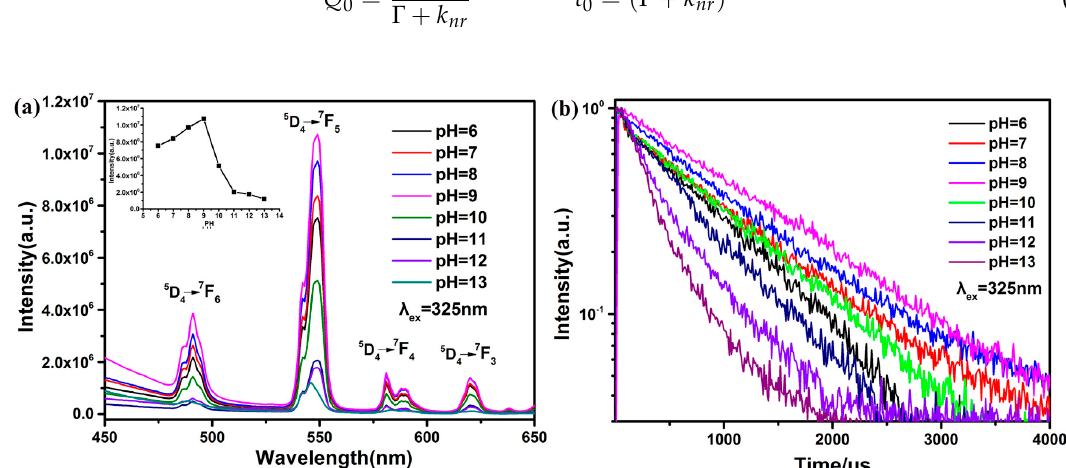
Figure 3. Changes in fluorescence emission and fluorescence lifetime for Tb(acac) 3 phen complexes as a function of pH; ( a ) Fluorescence spectra of Tb(acac) 3 phen complex (inset shows changes at 548 nm, λ ex = 325 nm); ( b ) Room-temperature fluorescence decay curves of Tb(acac) 3 phen when excited at 325 nm and monitored at 548 nm. Table 1. The emission lifetimes of Tb(acac) 3 phen complexes with different pH. samples